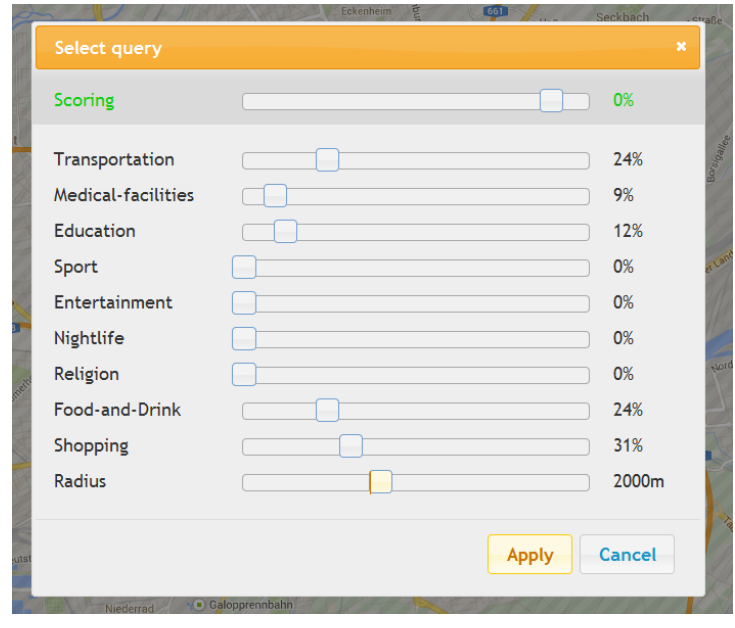
Figure 1 . Multi-criteria user